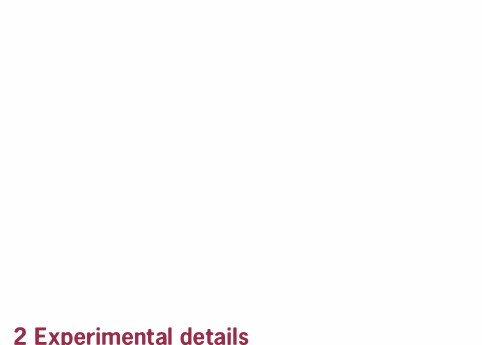
Fig. 2: Comparison between complex t-1 and stationary (T I